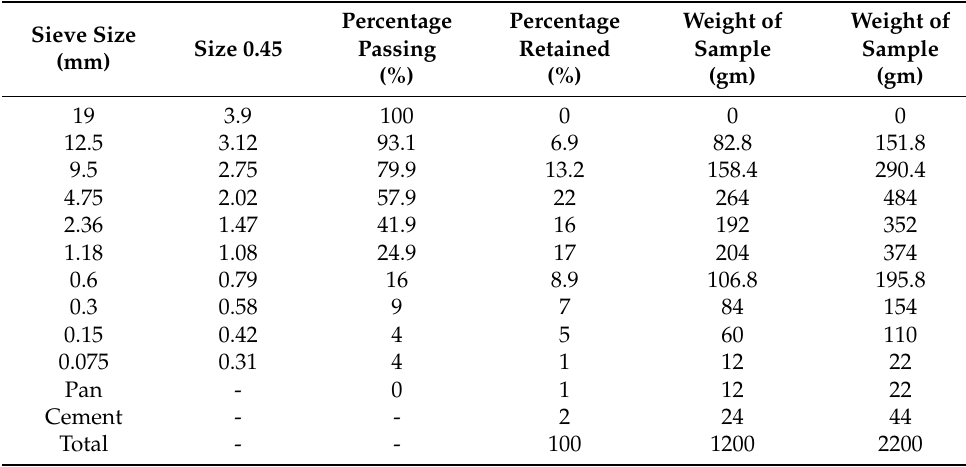
Table 7. Gradation for the 1200 and 2200 g asphalt mixture samples.